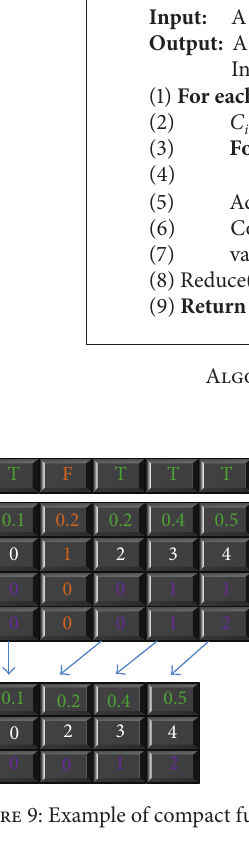
Algorithm Finding Split Points